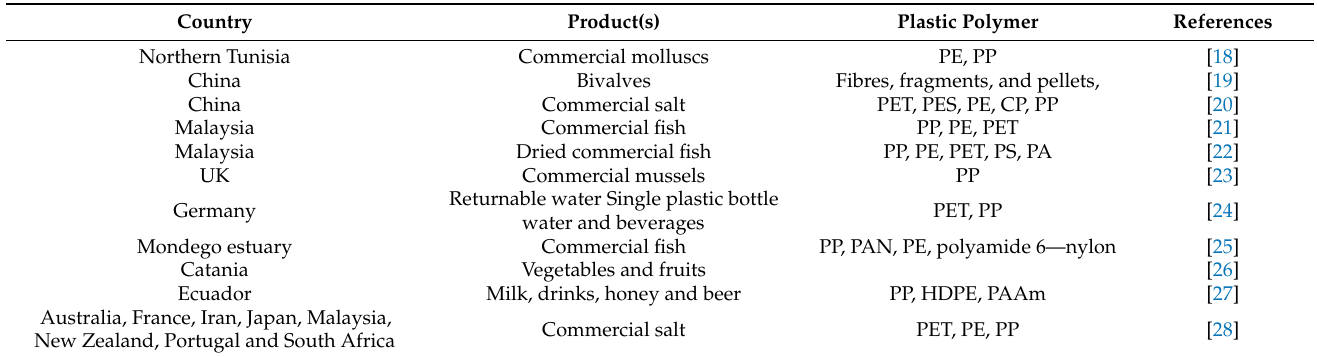
Figure 2. Routes of human exposure to MPs. Table 1. Some examples of microplastics containing foods, beverages and drinking water in the